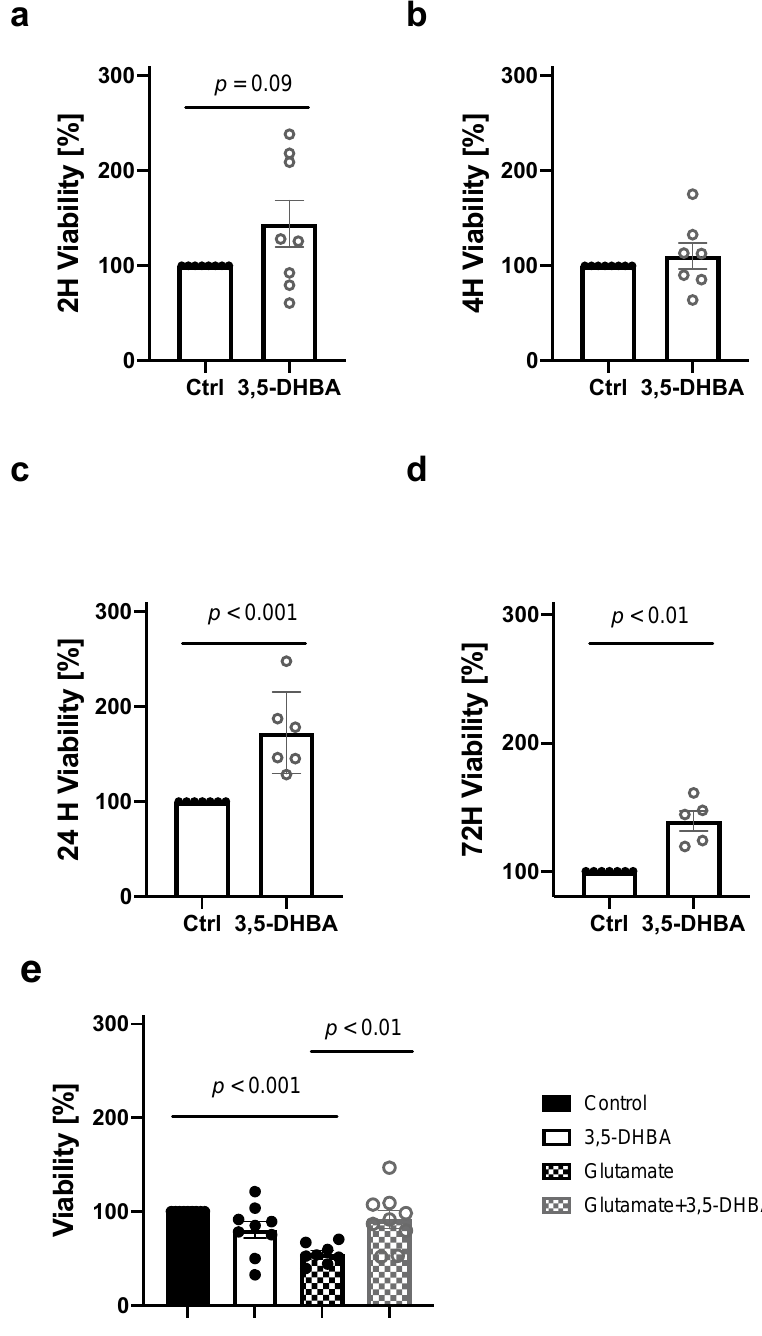
Figure 1. Retinal tissue viability is increased in response to 3,5-DHBA treatment. ( a – d ) Cell survival measured as lactate dehydrogenase (LDH) release from retinal explants incubated for 2, 4, 24, and 72 h. ( e ) Cell survival decreased during L -glutamate exposure, whereas the addition of 3,5-DHBA to glutamate-incubated retinas resulted in increased survival. Values are presented as mean ± S.E.M ( n = 5–8 retinal quarters originating from five to eight different whole retinas). Statistics: Unpaired t -test for figure a–d. One-way ANOVA followed by Tukey’s multiple comparisons test for Figure 1e.